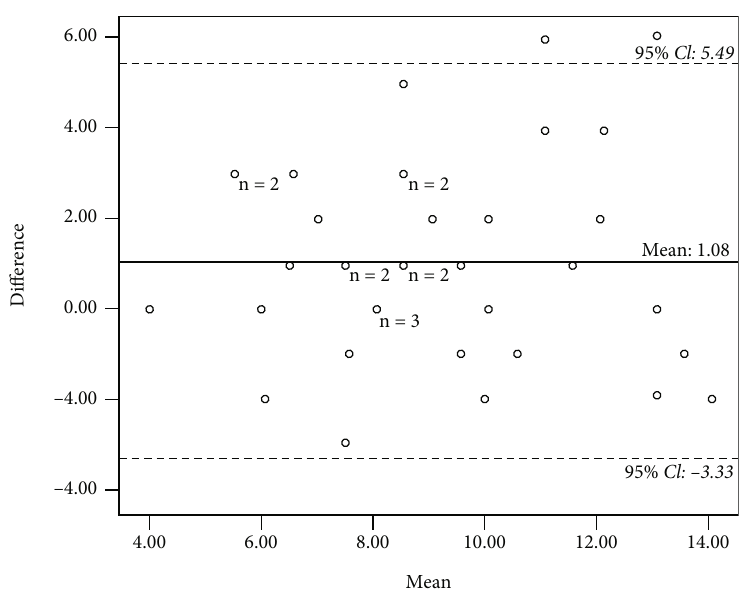
Figure 4: Bland-Altman plot for test-retest reliability (video).